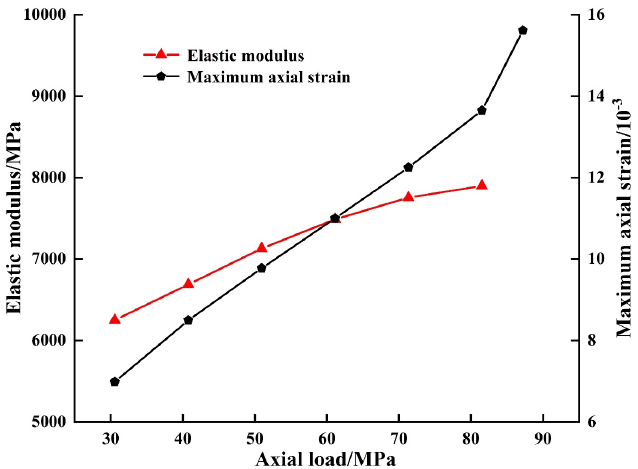
Figure 5. Mechanical indexes at different upper stresses.